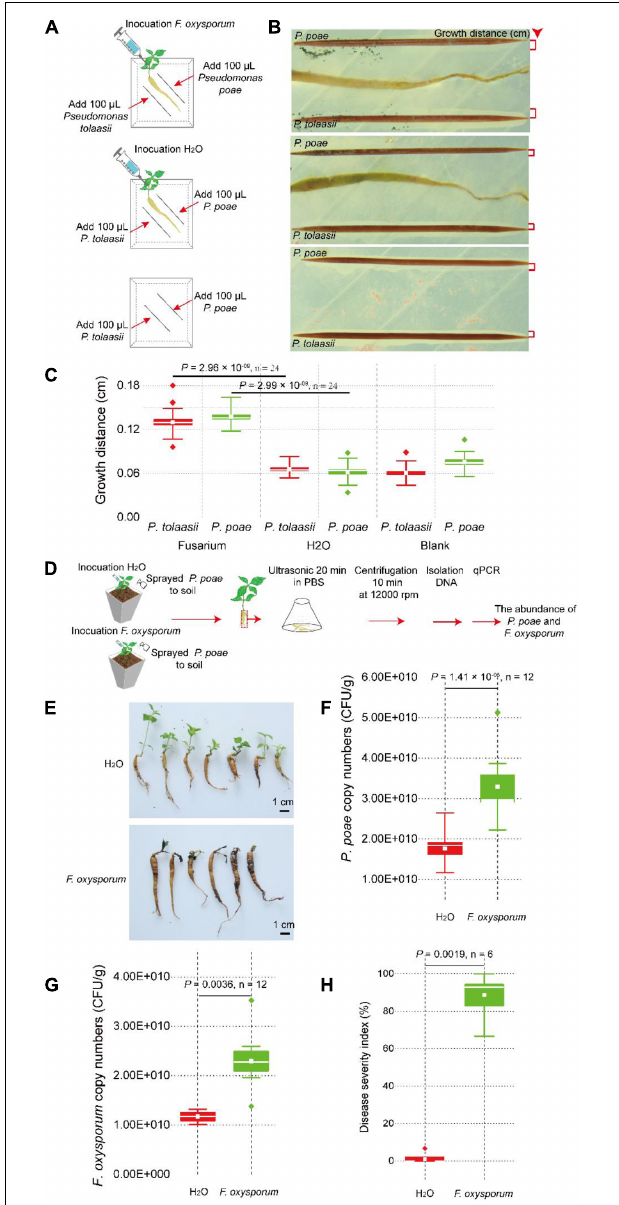
FIGURE 6 | Pseudostellaria heterophylla inoculated with F. oxysporum attracted P. poae and P. tonnasii in agar medium. (A) Two-week-old plants with the same growth vigor were selected and transferred to the center of the agar medium. They were inoculated with 10 µ l of F. oxysporum spores (concentration = 5 × 10 5 CFU/ml) or 10 µ l of ddH 2 O. After 7 days, a sterilized toothpick was placed parallel to the tuberous root at a 1-cm distance, and 100 µ l of new cultures of strains Pseudomonas poae or P. tonnasii (OD600 = 1) were inoculated on the toothpick. The growth distance of Pseudomonas was calculated by ImageJ software, as shown in (B,C) . (D) P. heterophylla inoculated with F. oxysporum attracted the P. poae in the soil. (E) The FW severity in plants treated with or without F. oxysporum . (F) The density of P. poae in tuberous roots inoculated with F. oxysporum or H 2 O. (G) Changes in the F. oxysporum abundance in tuberous roots inoculated with F. oxysporum or H 2 O. (H) Changes in the disease severity index (DSI) of P. heterophylla with or without inoculated F. oxysporum . The two-tailed Wilcoxon test evaluated the significant